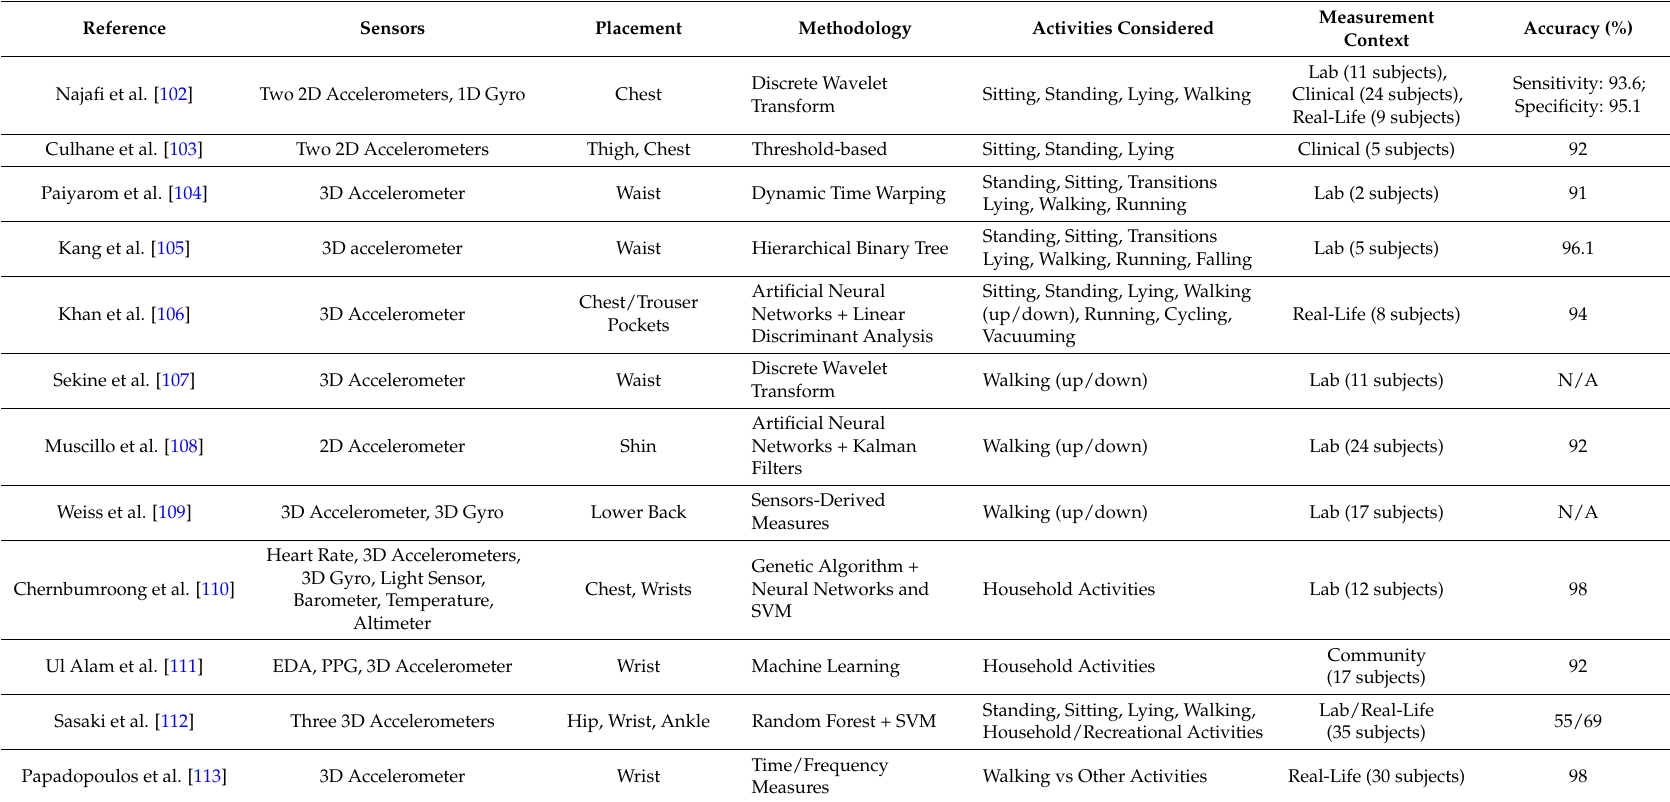
Table 2. Activity Classification Algorithms for Senior